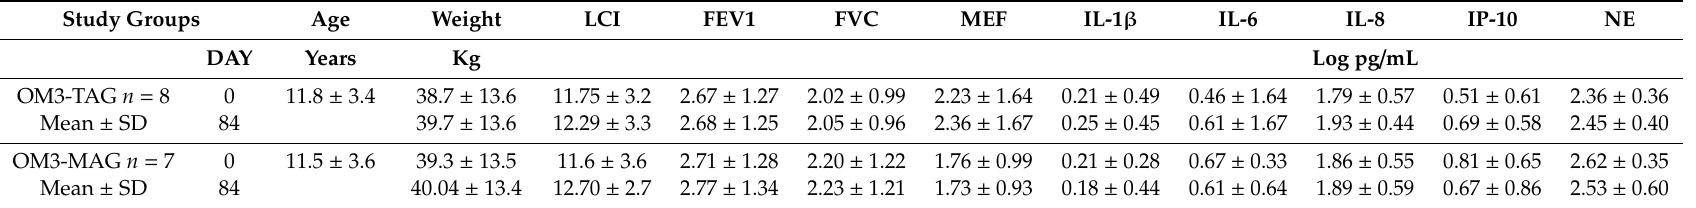
Table 7. Clinical Trial C: Study group characteristics / lung function